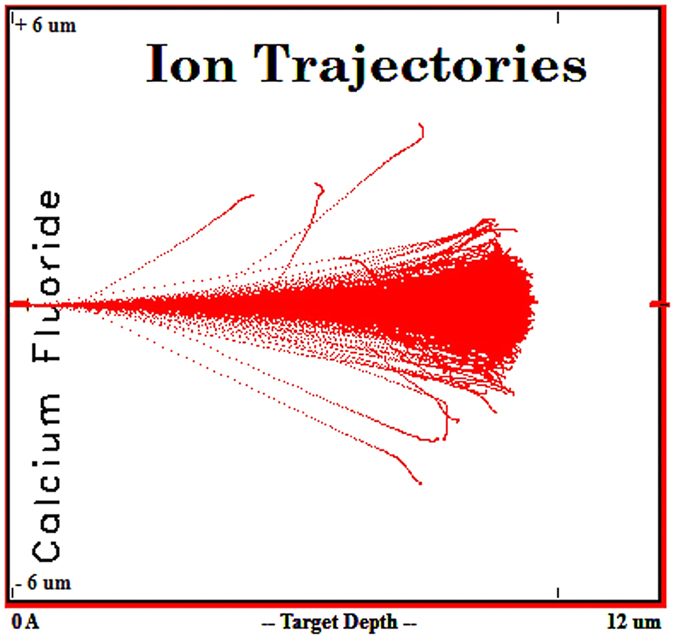
Result of the penetration depth simulation and scattering pattern of alpha particles in CaF2.